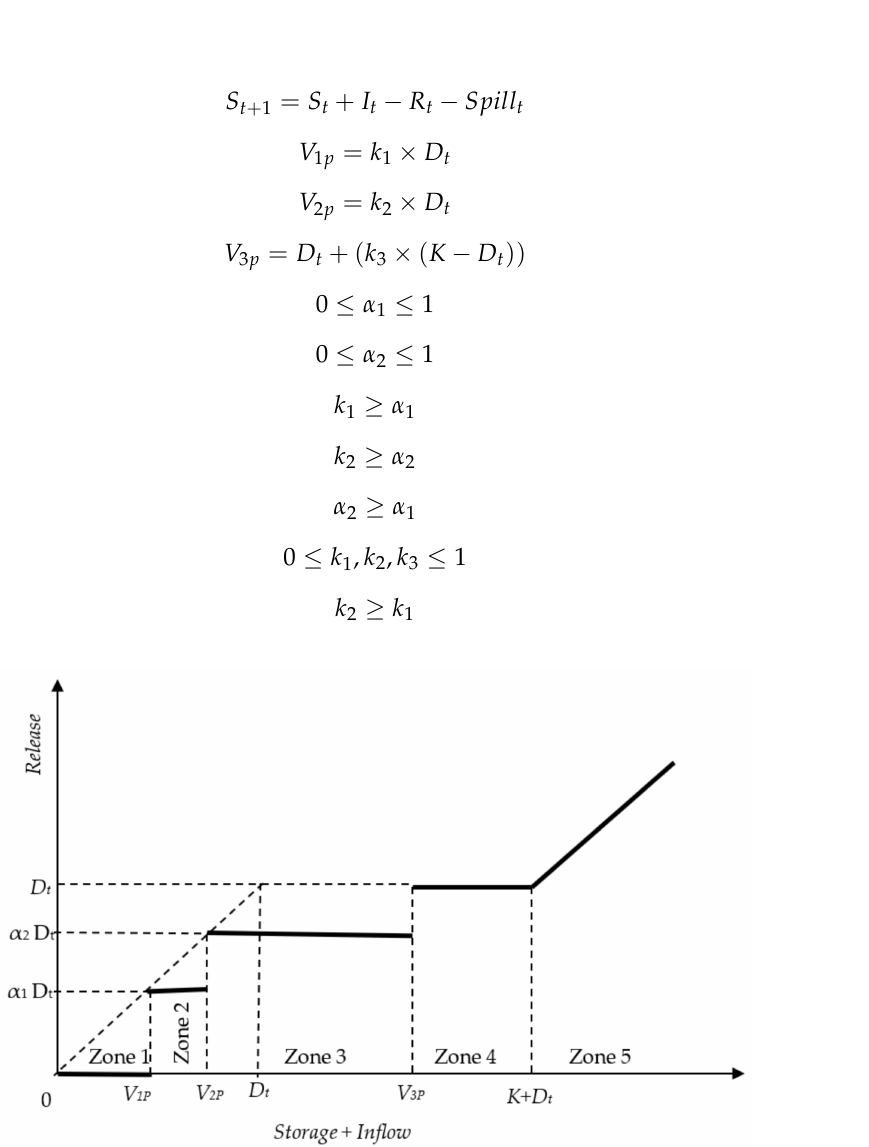
Figure 3. Discrete hedging policy ( D t —demand, α 1 , α 2 -rationing factor; and, t denotes time